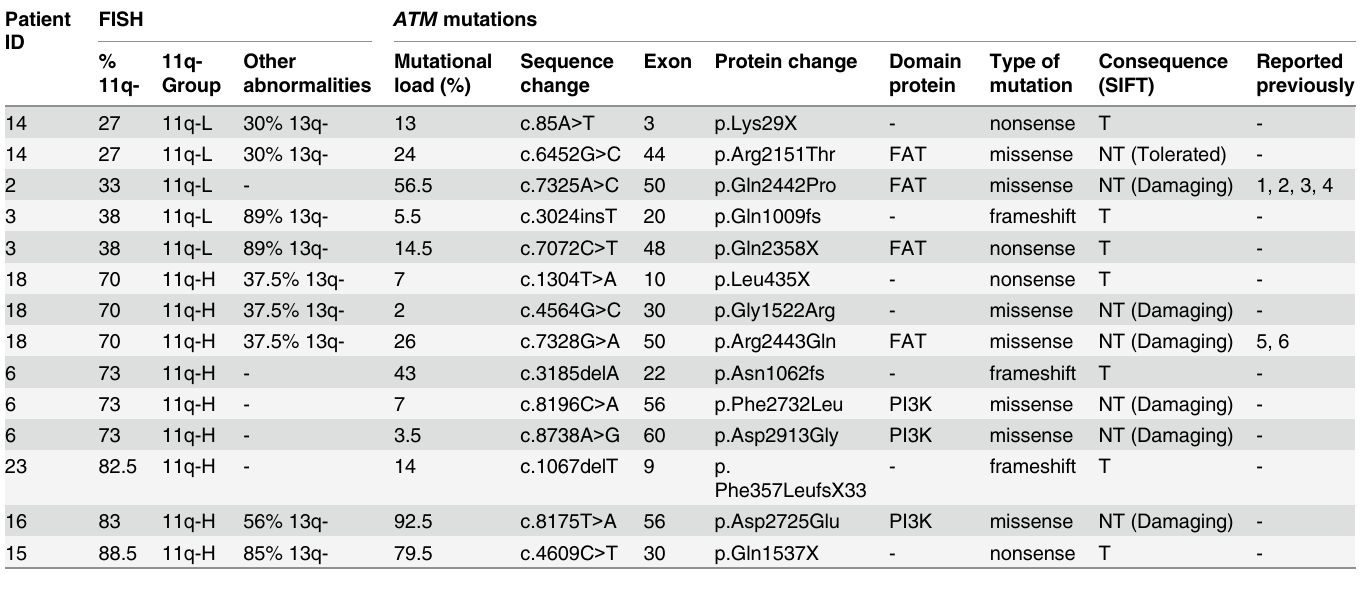
Table 4. ATM mutations in 25 CLL patients with